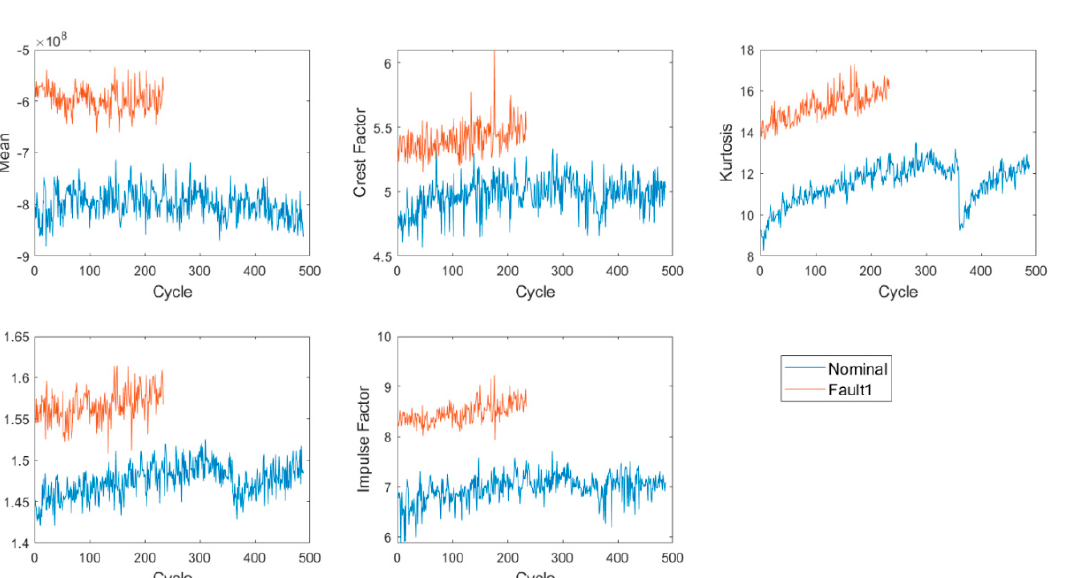
Table 8. Cluster local parameter obtained from the pretraining phase (sealing group).